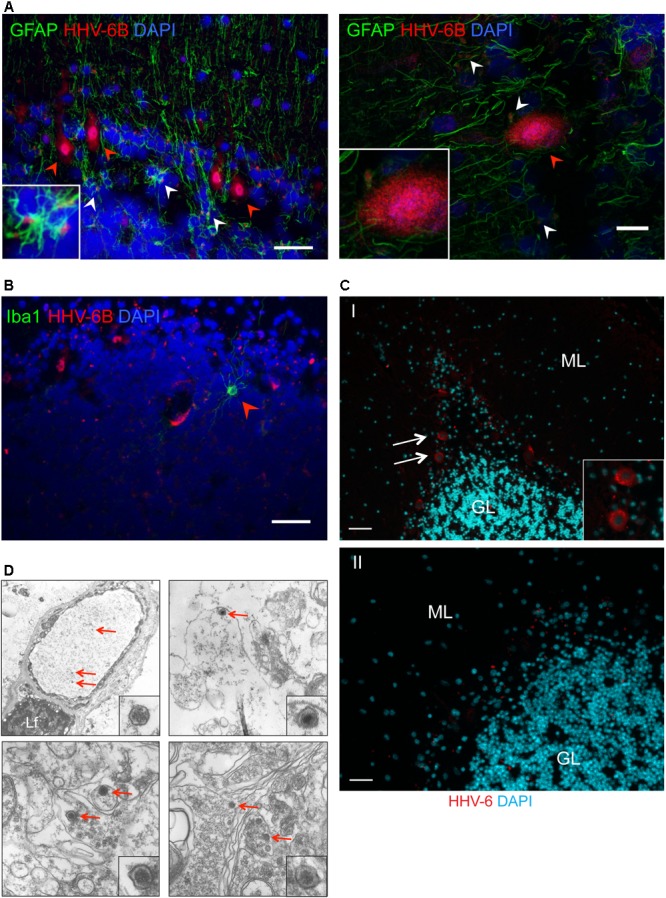
Detection of HHV-6 in Purkinje cells and other associated cell types. (A) Immuno-fluorescence analysis to study HHV-6 infection in astrocytes within cerebellar cortex samples. Cryo-sectioned cerebellar cortex samples were co-stained using monoclonal antibodies against OHV3 together with GFAP (marker for astrocytes). Left panel shows a representative image taken with epifluorescence microscope whereas the right panel shows a representative image taken with confocal microscope. HHV-6 positive Purkinje cells are marked with red arrowheads. HHV-6 positive astrocytes are marked with white arrowheads. (B) Immuno-fluorescence analysis showing status of HHV-6 infection in microglial cells within cerebellar cortex samples. Cryo-sectioned cerebellar cortex samples were co-stained using monoclonal antibodies against OHV3 together with Iba1 (marker for microglia). Iba1 positive microglial cells are marked with red arrowheads. (C) FISH analysis in FFPE samples of cerebral cortex region detected HHV-6 positive Purkinje cells (marked with white arrows). ML, molecular layer; GL, granular layer. Panel I shows a representative image of positive staining for HHV-6 while panel II shows a representative image for negative staining for HHV-6. The scale bars represent (indicated with white lines) 200 μm. (D) Transmission electron microscopy was used to identify HHV-6 viral particles (marked with red arrows) in randomly selected samples positive for HHV-6 by both qPCR and IFA. Lf, lipofuscin.